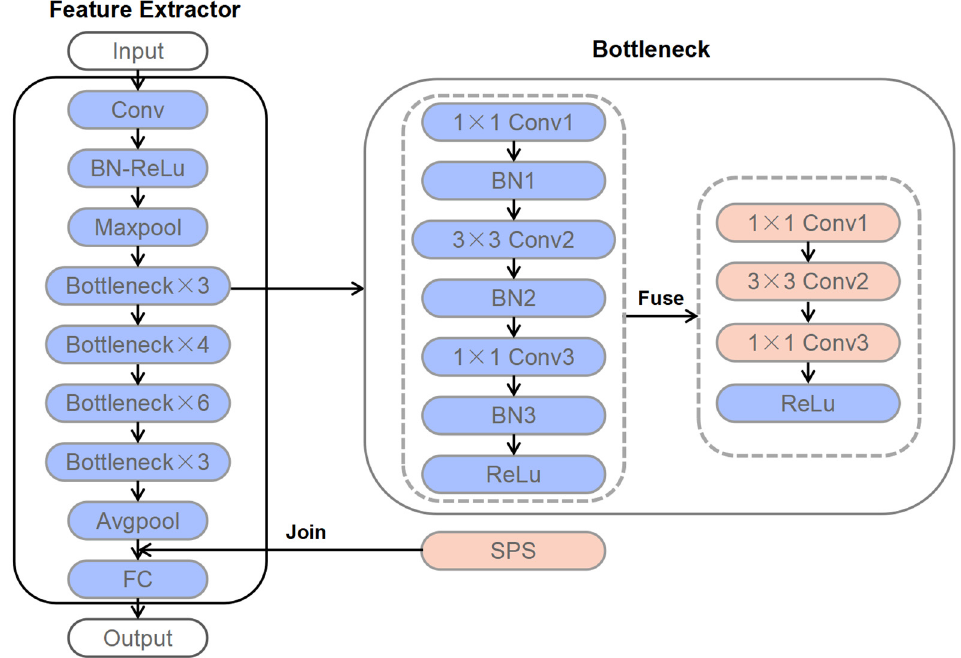
Figure 3. The network structure of ResNet50 shows where changes exist. The SPS is added after the average pooling layer. These two layers are replaced with a single convolutional layer.